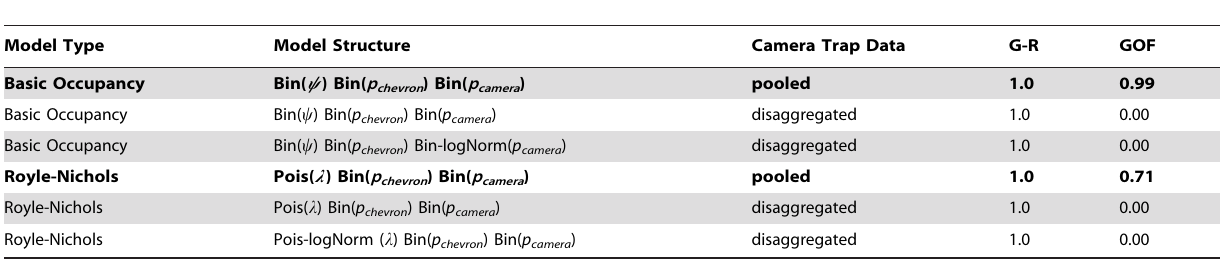
Table 2. General model structures evaluated for convergence properties and goodness of fit (GOF).